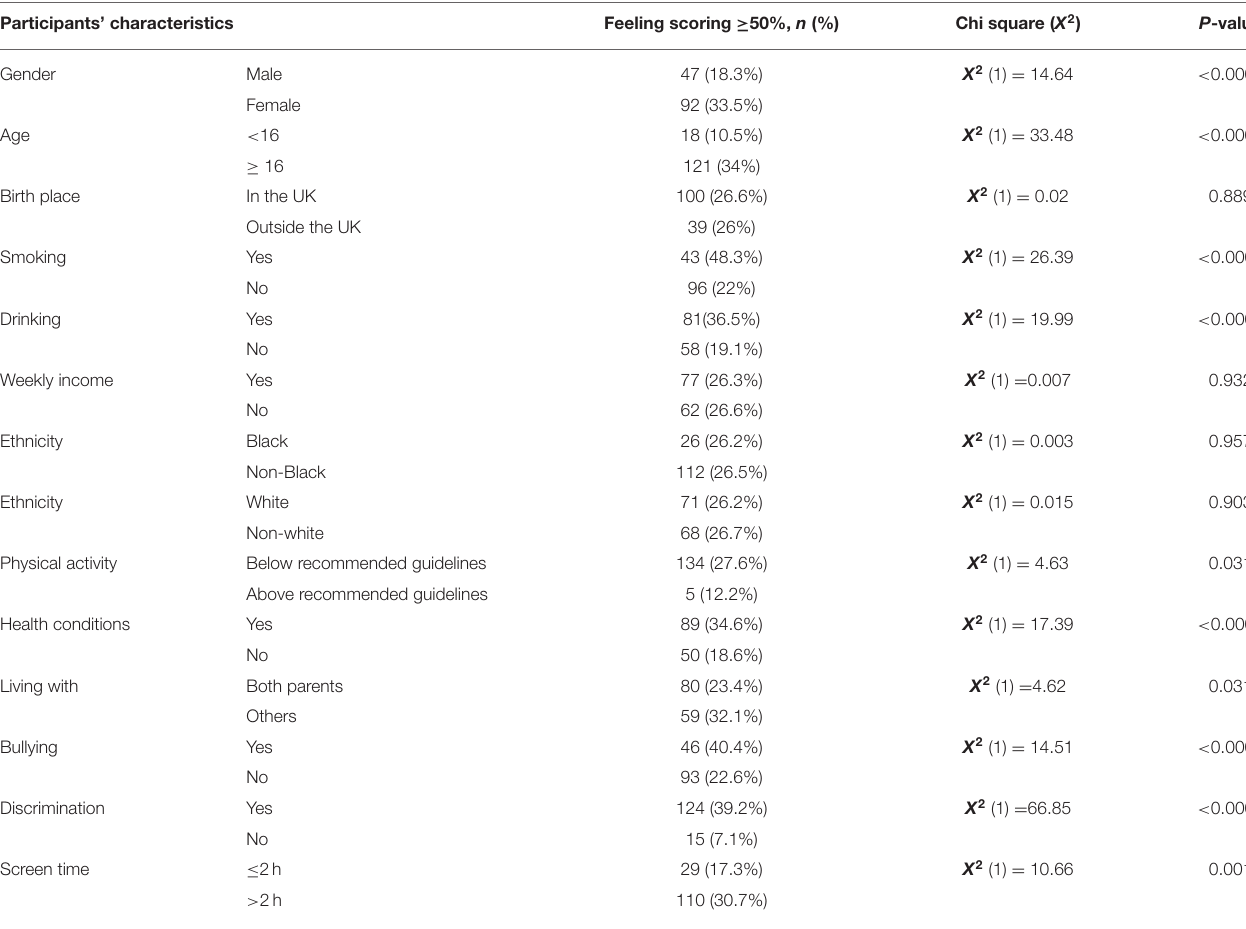
TABLE 3 | Association of sociodemographic factors, bullying, and discrimination with mental health (dominance of negative mental feelings). Participants’